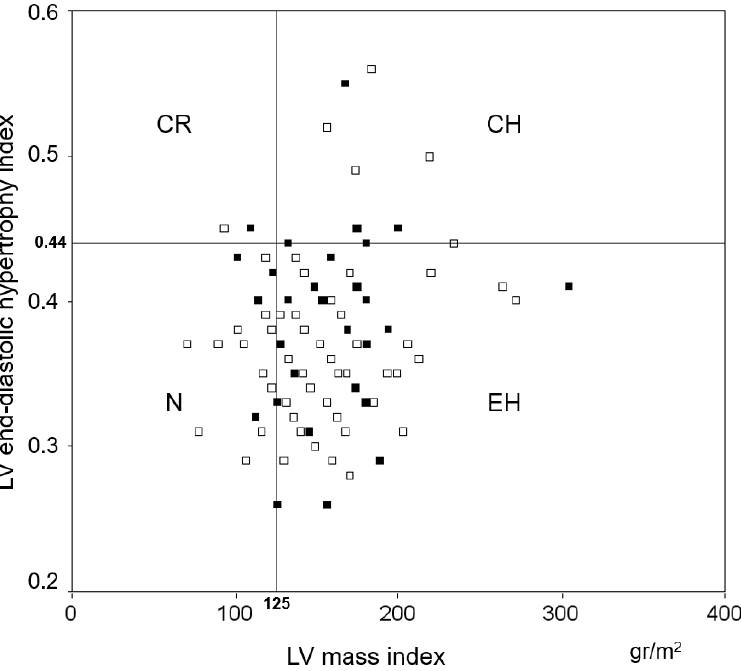
Figure 2. Distribution of left ventricular (LV) geometry in the whole population. The majority of patients is positioned in the LV eccentric hypertrophy quadrant (75%). The absence of a relation between LV geometry and LA compliance can also be appreciated (empty squares: normal LA compliance; filled squares: reduced LA compliance). CH: concentric hypertrophy; CR: concentric remodeling; EH: eccentric hypertrophy; LA: left atrial; N: normal. At multiple regression analysis, the determinants of LVMI (r = 0.62, p < 0.001) were the waist/hip ratio (B = 161, SE = 48, p = 0.001), DAP (B = 1.7, SE = 0.38, p < 0.001), and HR (B = − 1, SE = 0.34, p = 0.003), whereas the independent predictors of E/A (r = 0.76, p < 0.001) were age (B = − 0.014, SE = 0.002, p < 0.001), HR (B = − 0.016, SE = 0.004, p < 0.001), and the presence of MetS (B = − 0.24, SE = 0.09, p = 0.01). When the MetS factor was excluded from